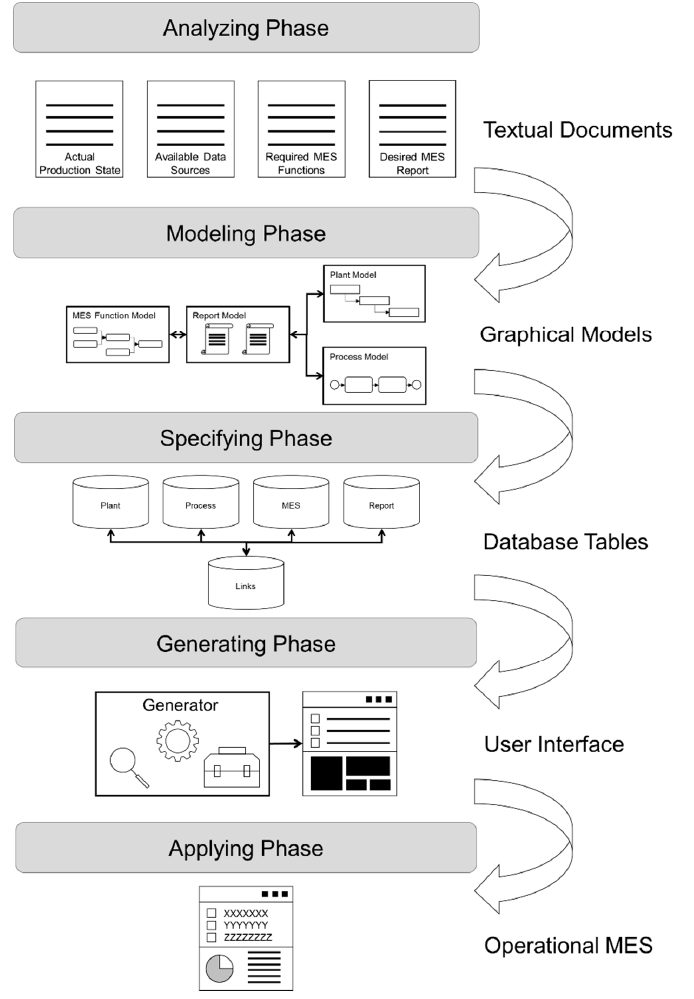
Figure 2. Five phases of the approach for model-driven engineering of Manufacturing Execution Systems (MES) .